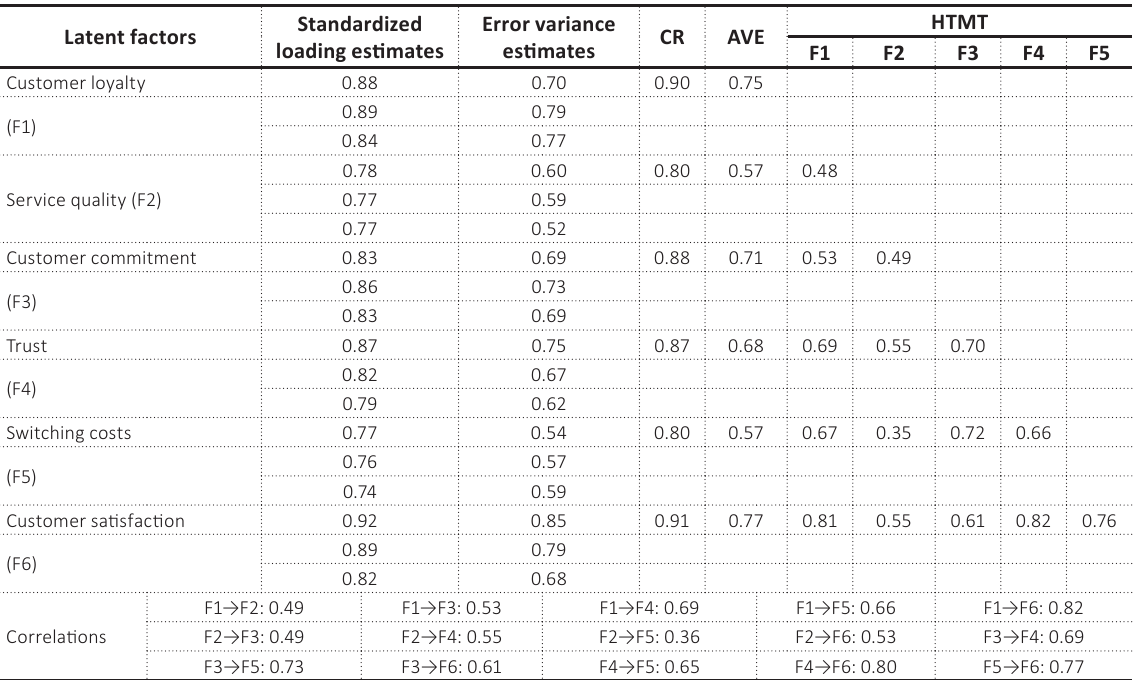
Table 3. Measurement model